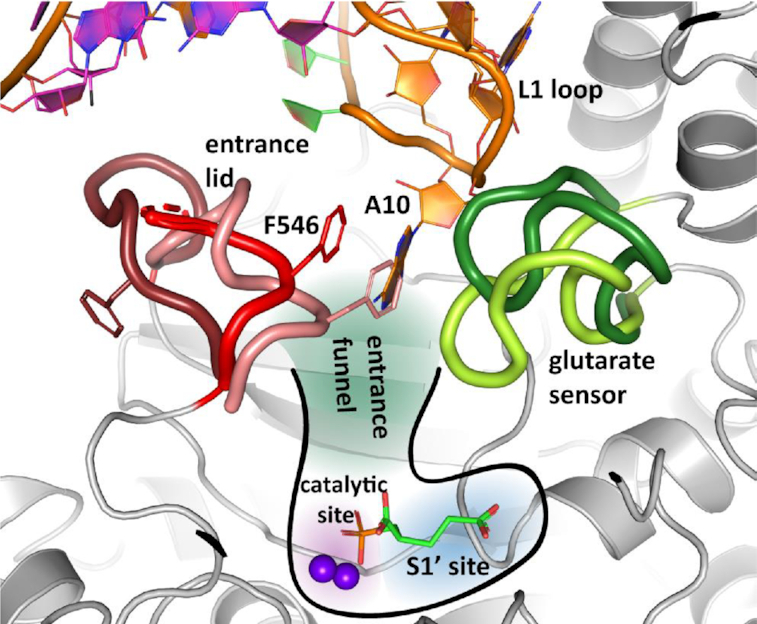
Flexibility of the entrance lid and the glutarate sensor and their conformational changes upon A9g binding. Superposition of PSMA complexes featuring different conformations of the entrance lid (amino acids 541–548, red shades) and the glutarate sensor (amino acids 692–704, green shades). PSMA is shown in gray cartoon with entrance lid and glutarate sensor highlighted as thick ribbons. The position and shape of the internal pocket, together with S1′-bond 2-PMPA (sticks), are sketched, the zinc ions are shown as purple spheres. The entrance lid can adopt a continuum of conformations between the ‘open’ (dark red; PDB code: 3BI1) and the ‘closed’ conformation (light red; PDB code: 3BI0). The glutarate sensor conformations are likely bimodal and oscillate between ‘withdrawn’ (S1′ site empty, dark green; PDB code 2C6P) and the ‘binding’ states (S1′ site occupied, light green; reported here). The A10 nucleobase bridges the entrance lid and glutarate sensor and locks them in the ‘semi-closed’ (red) and ‘binding’ (light green) conformations, respectively, effectively blocking the internal cavity of the enzyme.